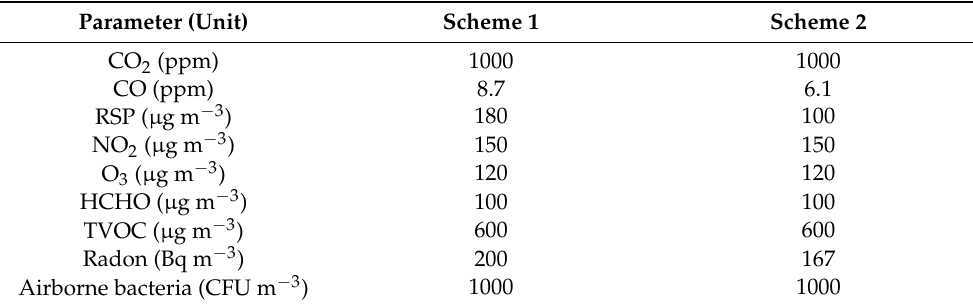
Table 1. 8 h exposure limits of satisfactory indoor air